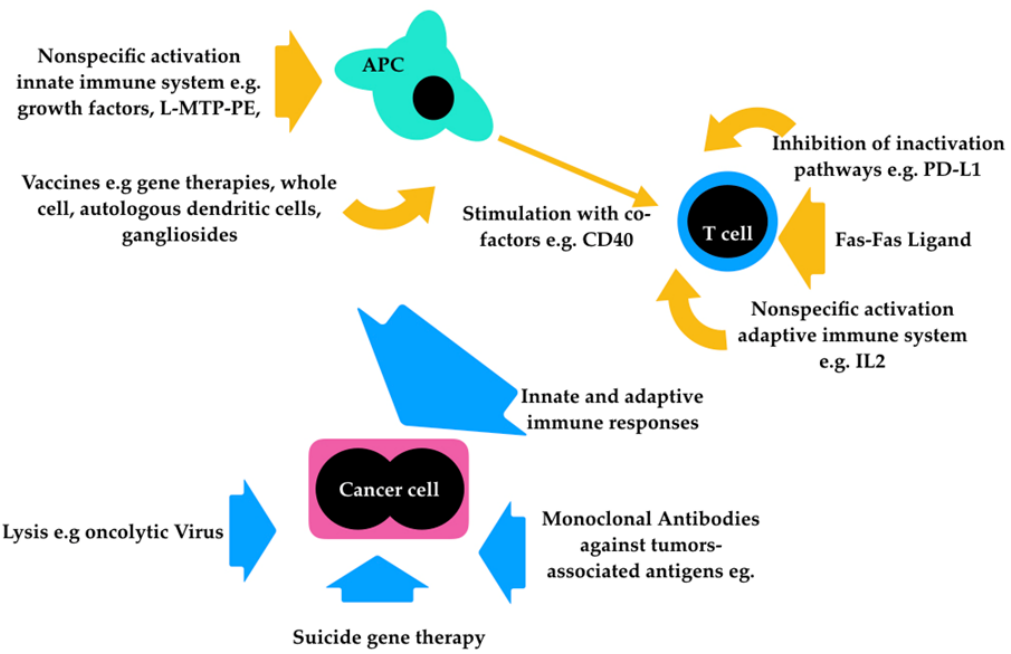
Figure 1. Summary of the different strategies for immunotherapy in CMM.